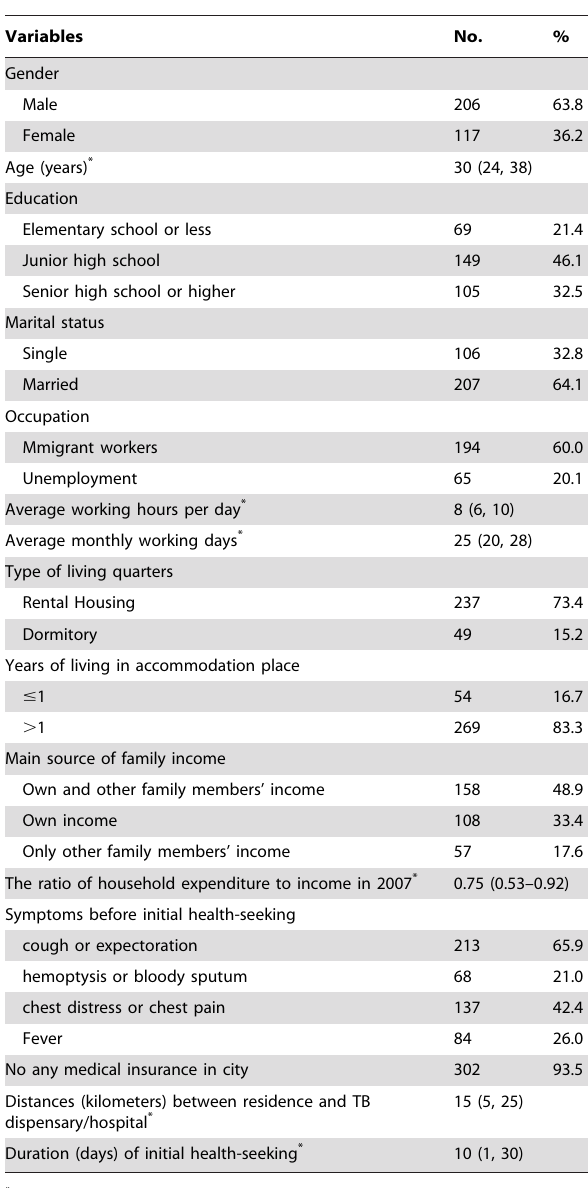
Table 1. Characteristics of new PTB cases among the migrant population recruited in Shanghai, Guangdong and Jiangsu, China, in